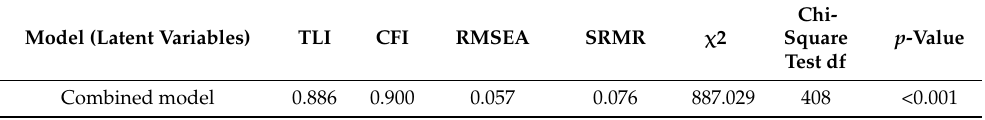
Table 2. Fit statistics for full measurement